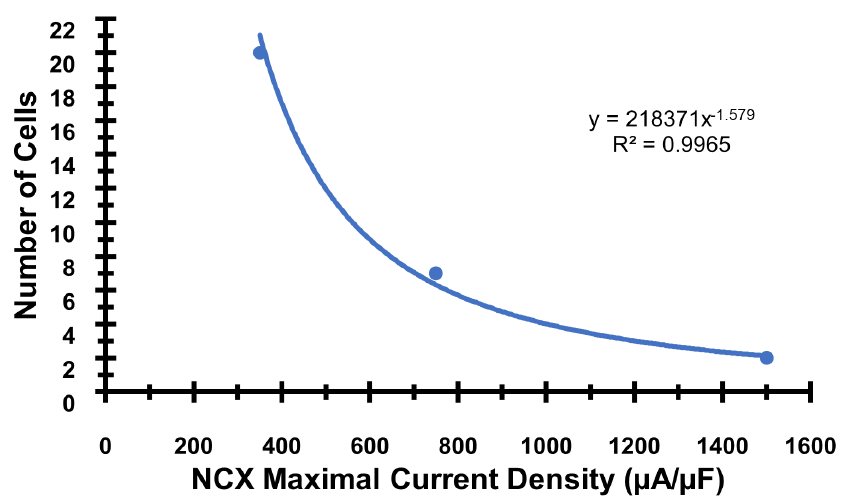
Figure A3. The number of cells needed to initiate a propagating AP increases as the maximal Na + - Ca 2+ exchanger maximal current density increases (equivalent to increase expression. The base value of v ncx used in the simulation is 750 s − 1 . The formula and R 2 for trendline is included in the inset.